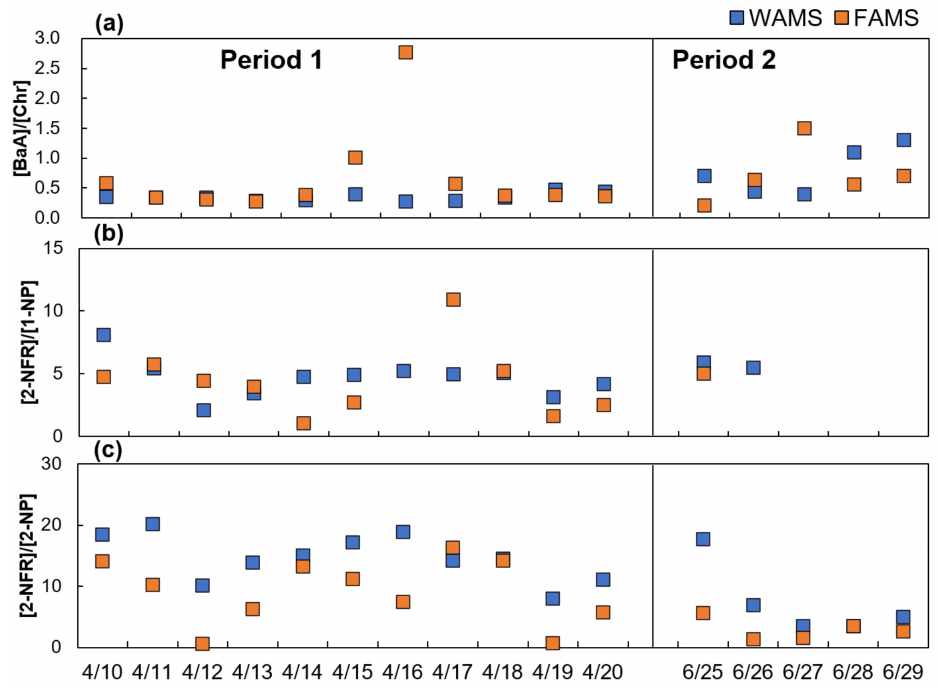
Figure 4. Diagnostic ratios of [BaA] / [Chr] ( a ), [2-NFR] / [1-NP] ( b ) and [2-NFR] / [2-NP] ( c ) at WAMS and FAMS in the East Asian winter monsoon period (Period 1, 10–20 April 2017) and summer monsoon period (Period 2, 25–29 June